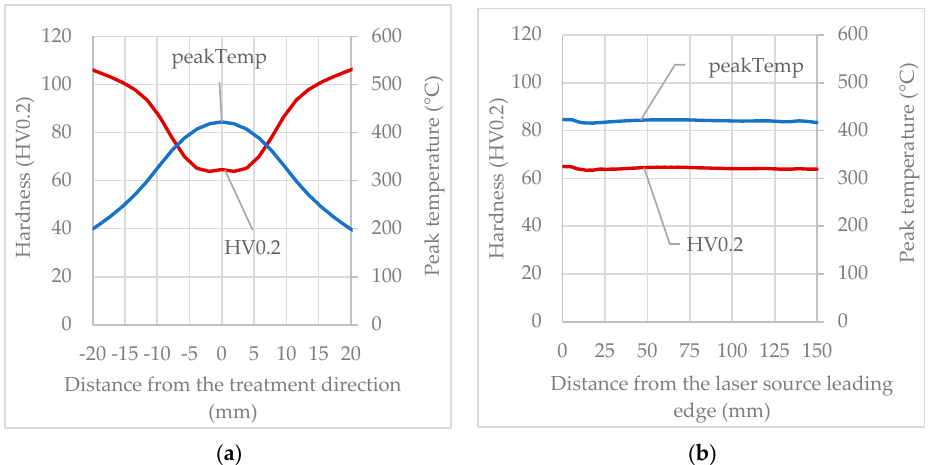
Figure 30. ( a ) Blank peak temperature distribution for the laser treatment carried out at the peak temper- ature of 420 °C and treatment speed of 5 mm/s; ( b ) Hardness distribution in the blank in T4 state for the laser treatment carried out at the peak temperature of 420 °C and treatment speed of 5 mm/s.